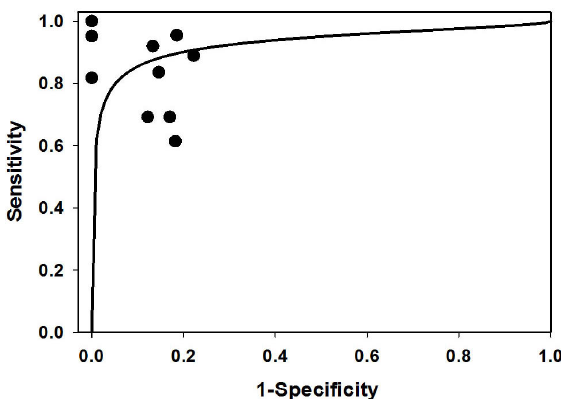
Figure 3. The SROC curve for different cancers with pooled studies of sensitivity and specificity. Exosomal miR ‐ 21 yielded an area under the SROC curve (AUC) of 0.93 with an overall sensitivity of 75% (0.70–0.80) and specificity of 85% (0.81–0.91) with their 95% CIs.